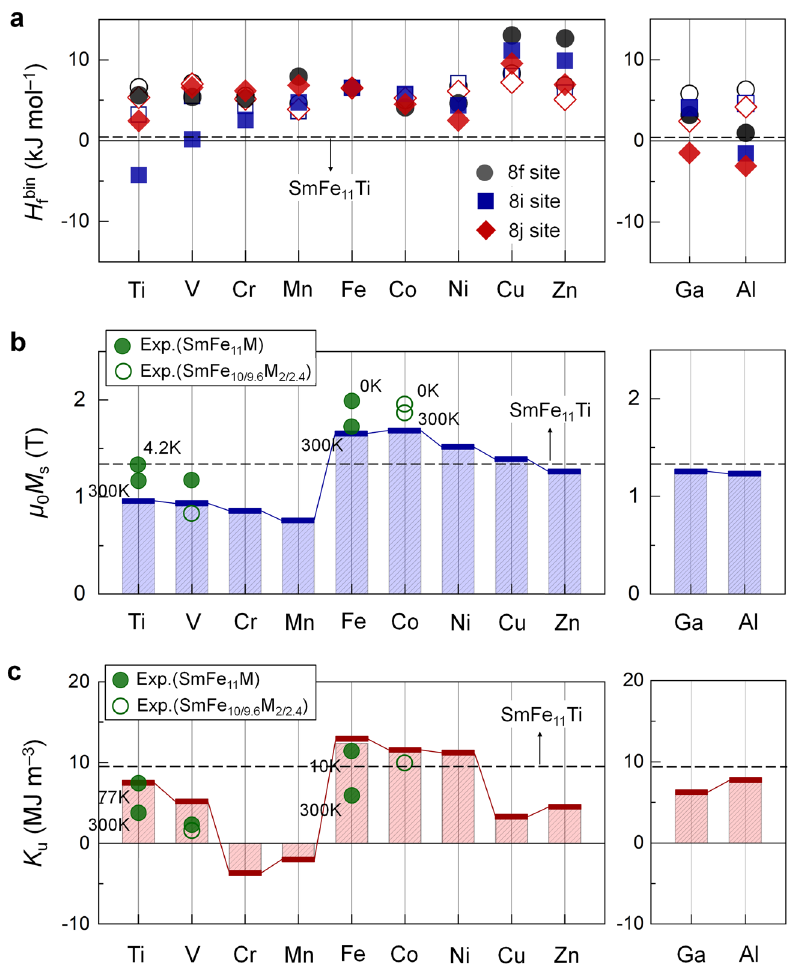
Fig. 3 Impact of single-element substitution on the stability and intrinsic magnetic properties at 0 K. a Formation enthalpy H bin of f SmFe 12 − x M x with x = 0.5 (open) and 2 (solid symbols) for M = Ti − Zn (transition metals), Ga and Al (simple metals) for the 8f, 8i, and 8j sites. value of SmFe 11 Ti, a threshold of the ThMn 12 -phase stability. b Saturation Horizontal dashed line corresponds to the calculated H bin f magnetization μ 0 M s and c uniaxial magnetocrystalline anisotropy K u of SmFe 10 M 2 with the preferred M site. Solid and open circles indicate the experimental data for SmFe 11 M and SmFe 10 V 2 /SmFe 9.6 Co 2.4 measured at 0 − 300 K 14 – 17,20 – 23 , respectively, where the result at 0 K is determined by fi tting with low-temperature measurements 22